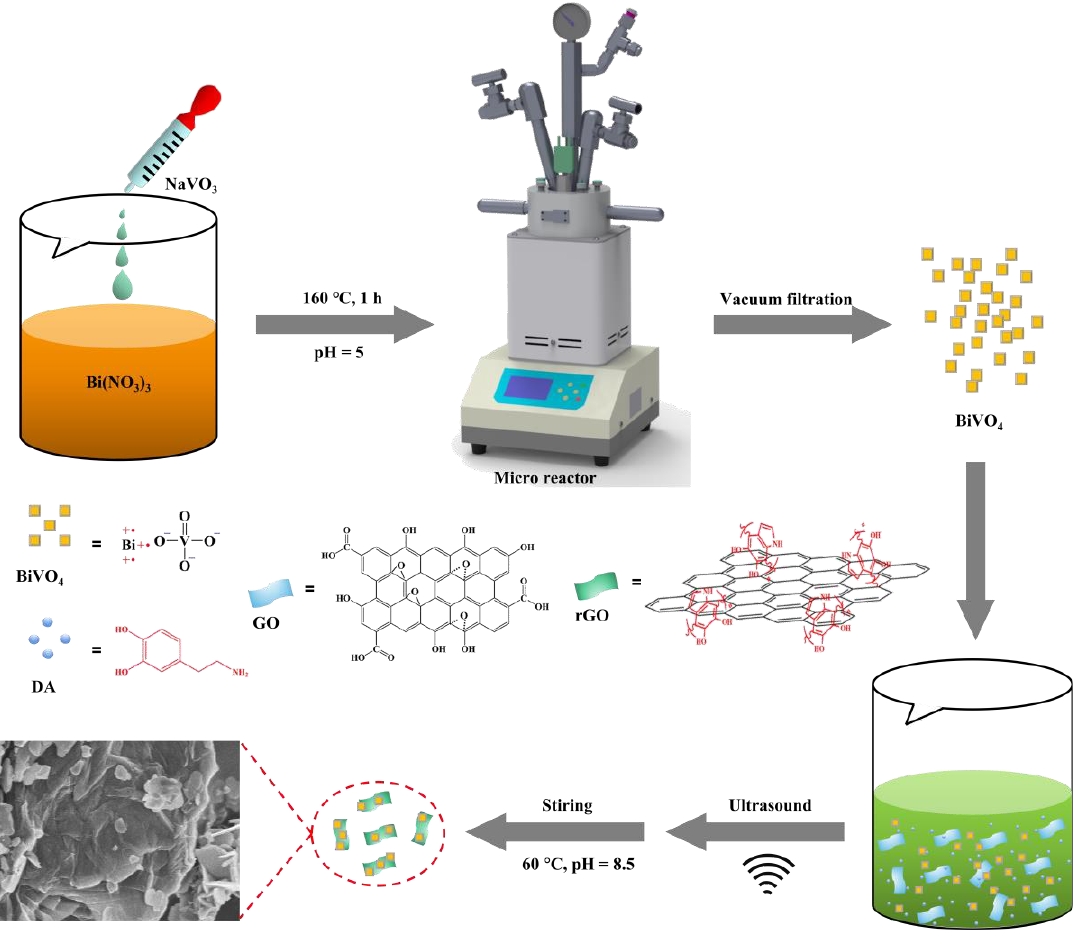
Figure 8. Preparation of PDA-rGO/BiVO 4 nanocomposites.